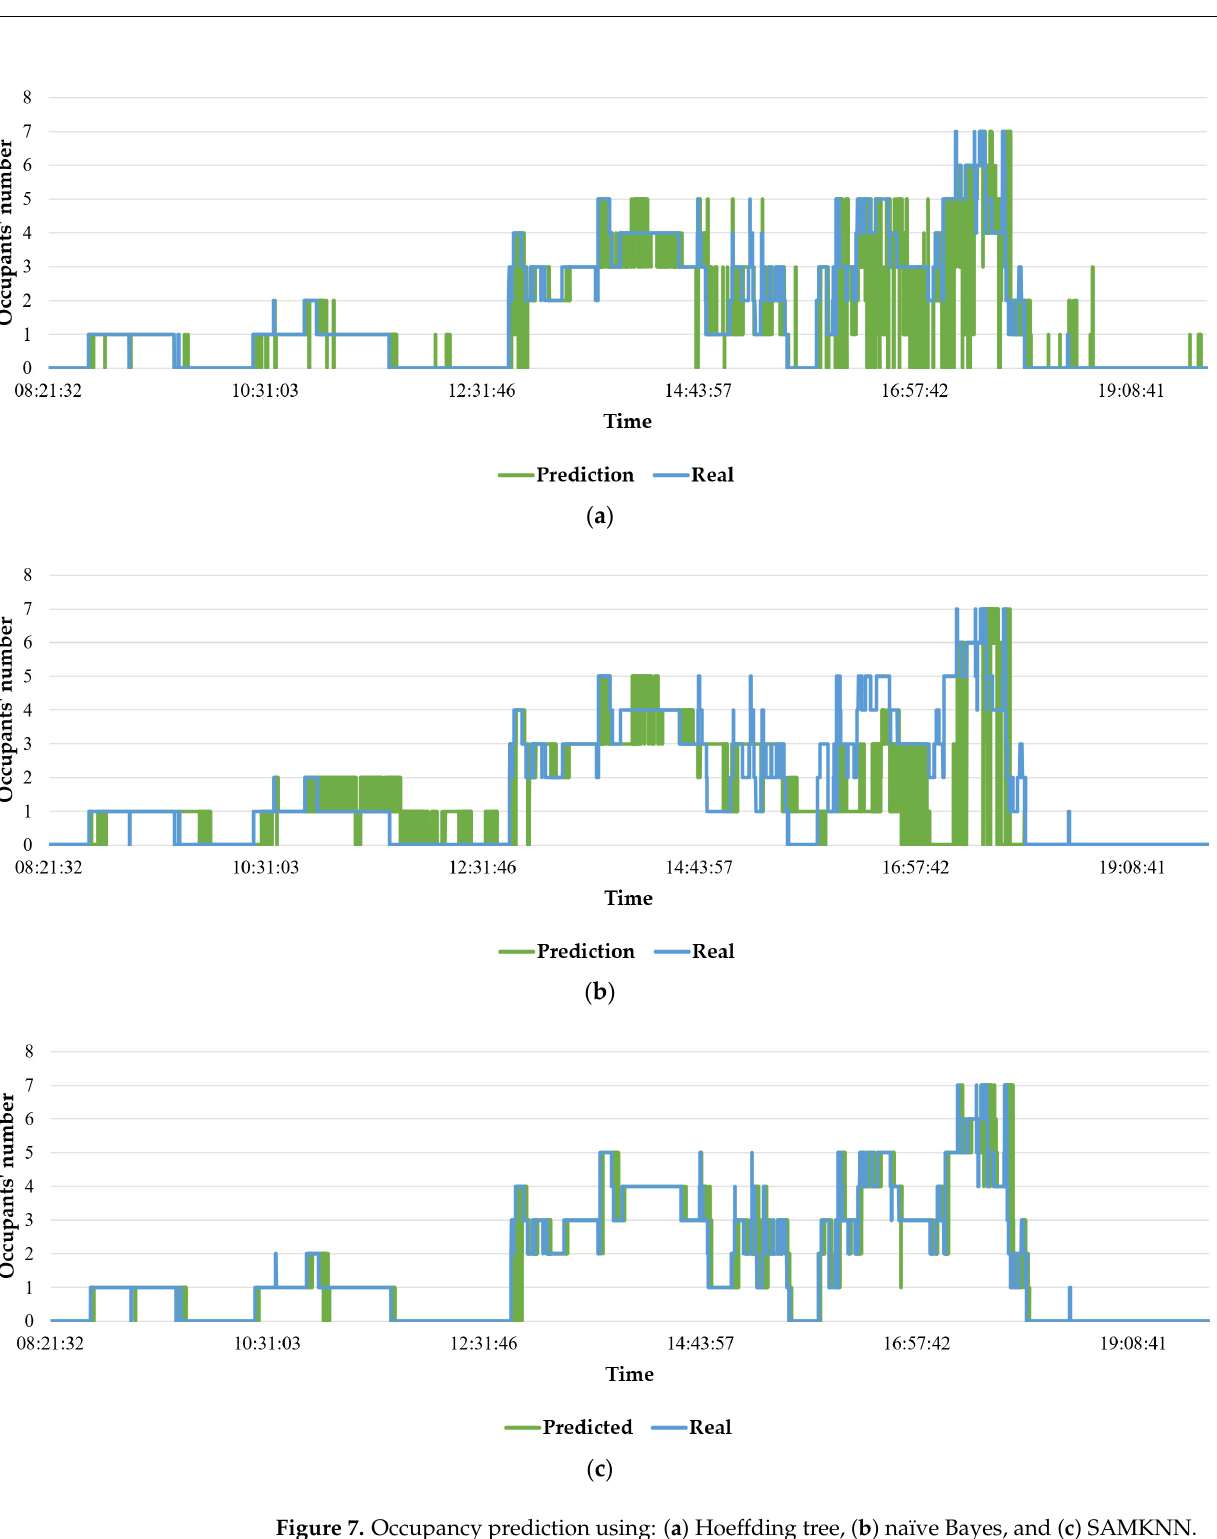
Figure 7. Occupancy prediction using: ( a ) Hoeffding tree, ( b ) naïve Bayes, and ( c ) SAMKNN .